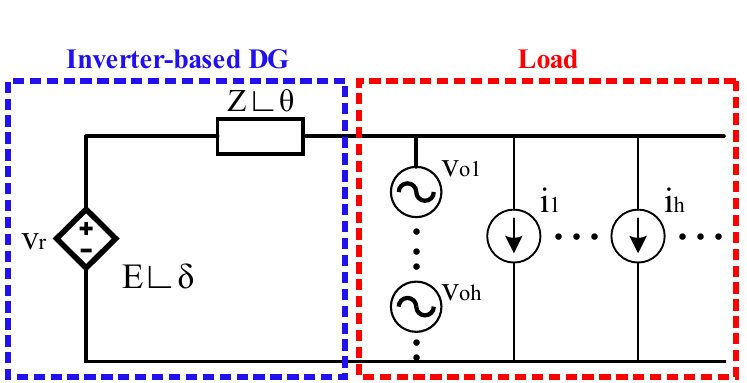
Figure 9. Inverter-based DG equivalent circuit connected to the load.